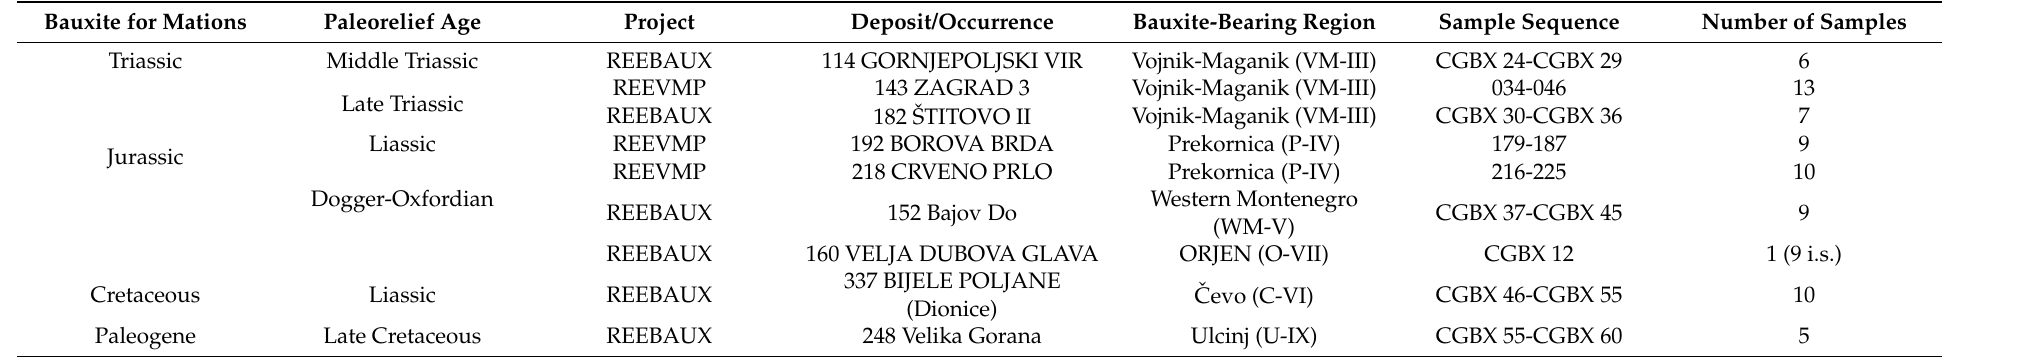
Table 3. Bauxite samples data from characteristic